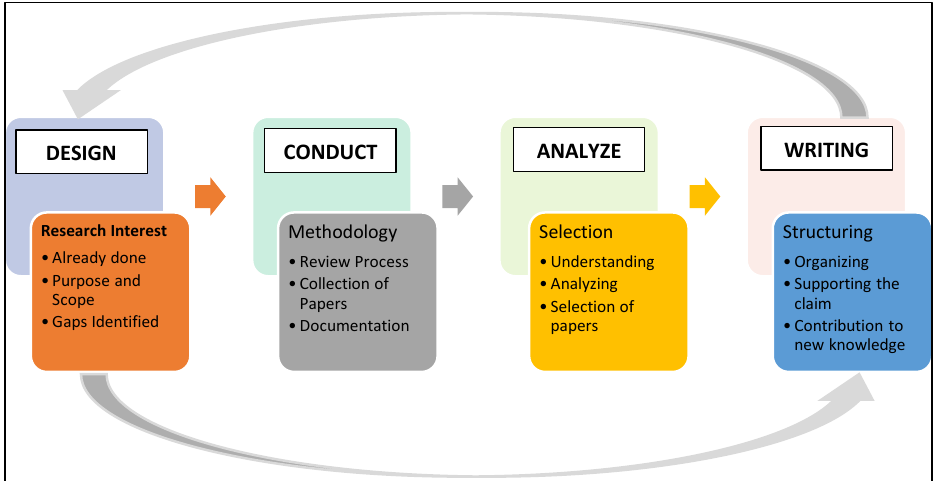
Figure 2. Review of literature analysis methodology (Adopted from Snyder,